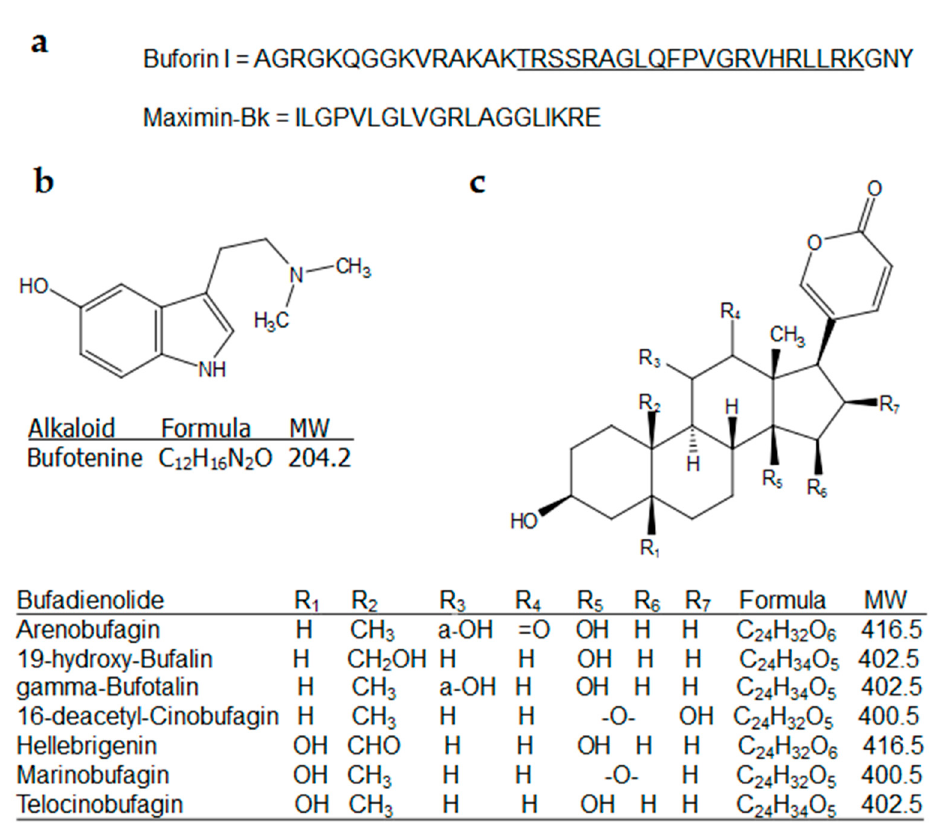
Figure 2. Chemical structures of antimicrobial molecules isolated from Bufonidae. ( a ) Primary structure of peptides; the underlined sequence in Buforin I represents the primary structure of buforin II. ( b ) Alkaloid. ( c ) Bufadienolides. MW: Molecular weight (g/mol).